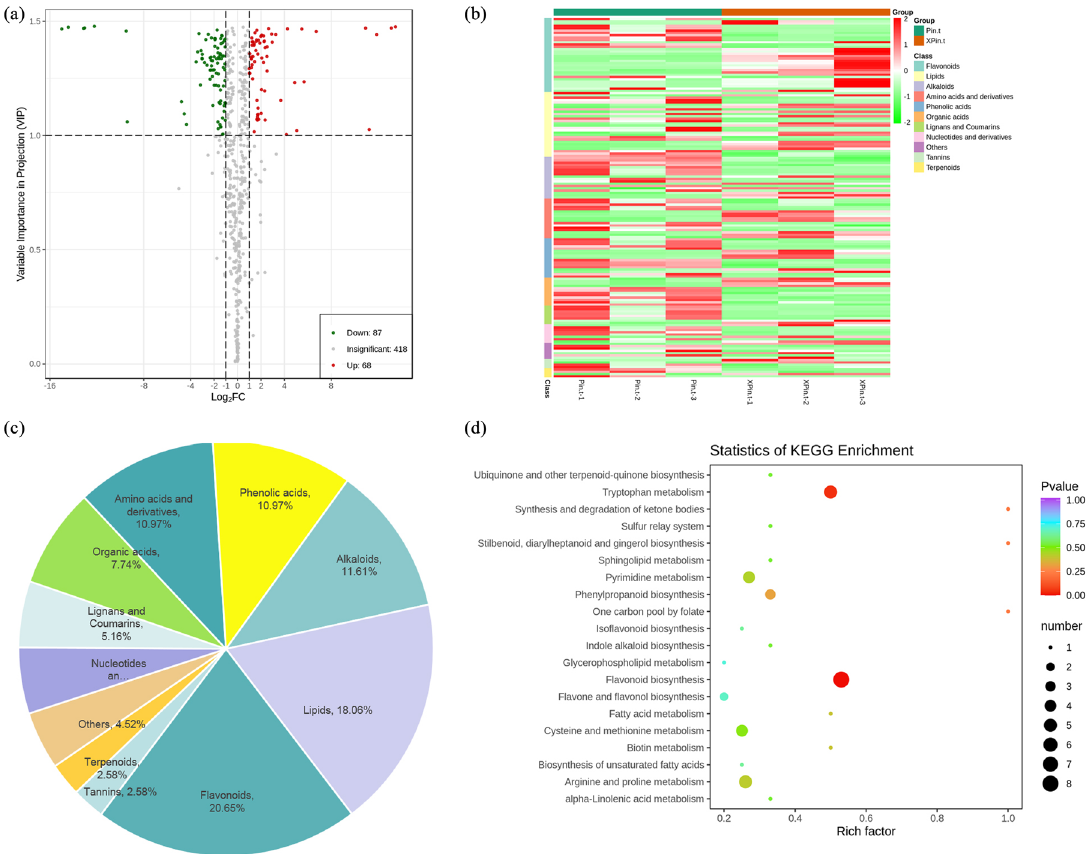
Figure 3: DAM between Pin.t and XPin.t. ( a ) A volcano plot of the di ff erential metabolites. Log 2 FC ≥ 1 or ≤ – 1 and VIP ≥ 1 were used as the screening criteria. ( b ) Heatmap of the di ff erential metabolites. ( c ) The types and proportions of the di ff erential metabolites. ( d ) An overview of the KEGG pathway analysis of the di ff erential